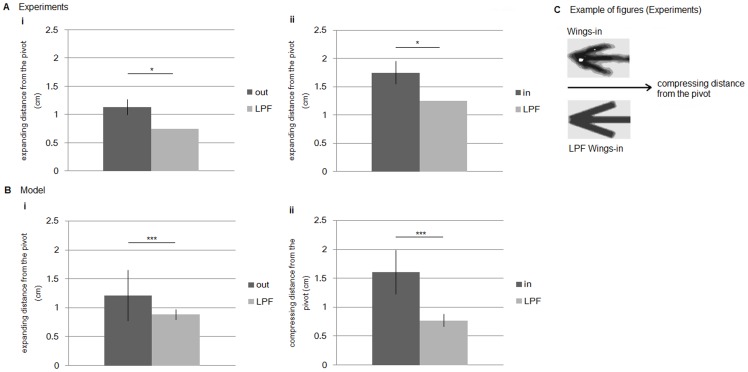
Average expanded (compressed) positions from the experimental results (actual ant concentration) and low-pass filtered results.(a). Experimental results. “Out” (“In”) indicates experimental Wings-out (Wings-in) results; “LPF” indicates low-pass-filtered effect results. (b) Model results. (c). Schematic figures of compressed positions (Wings-in) of experimental results. Lateral lines indicate error bars. *P<0.05.